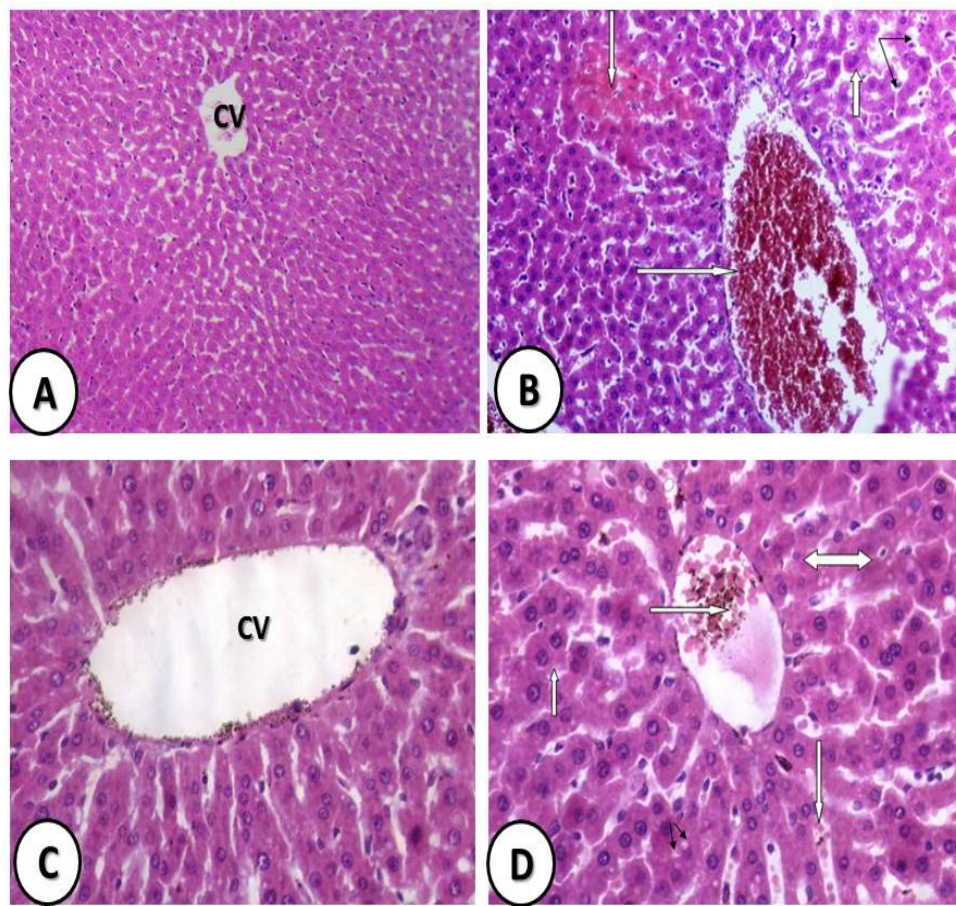
Figure 8. Photomicrographs of H&E-stained sections in the liver of the ( A ) control group showing normal hepatic cells and ( B ) sodium fluoride (NaF)-treated male rats showing a photomicrograph